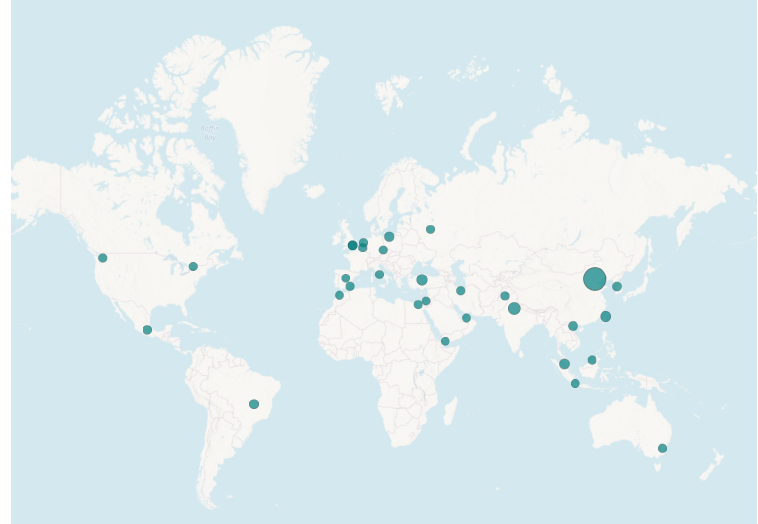
Figure 4. Global geographic distribution of publications based on the country of authors.